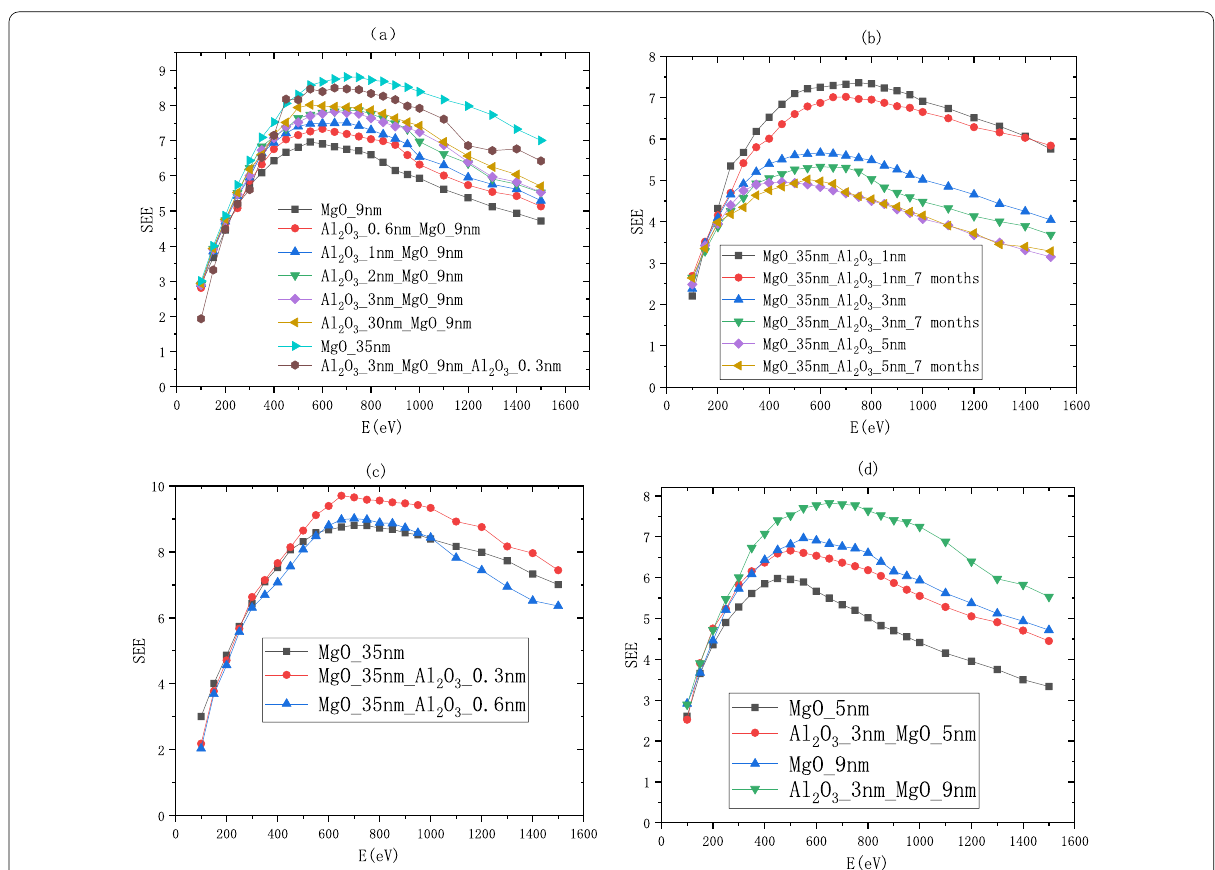
Fig.12 Change of secondary electron emission coefficient with different incident electron energy, a shows the information of Al 2 O 3 /MgO (on the silicon wafer, grow xnm-Al 2 O 3 , and then grow 9 nm-MgO), b shows the information of MgO/Al 2 O 3 and deliquescent MgO/Al 2 O 3 (on the silicon wafer, grow 35 nm-MgO, and then grow 1 nm-Al 2 O 3 ), c shows the information of MgO/Al 2 O 3 (on the silicon wafer, grow 35 nm-MgO, and then grow 0.3 nm-Al 2 O 3 ), and d shows the information of Al 2 O 3 /MgO (on the silicon wafer, grow 3 nm-Al 2 O 3 , and then grow 5